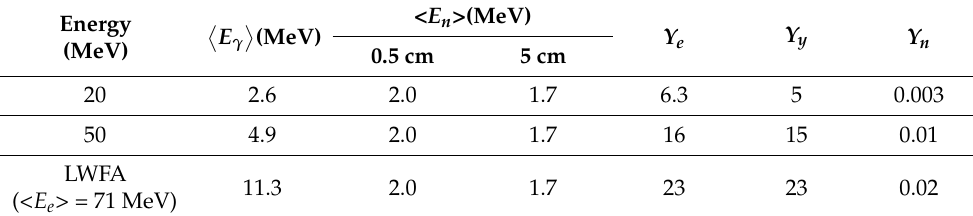
Table 1. Yields and average energies for the monoenergetic and LWFA electron